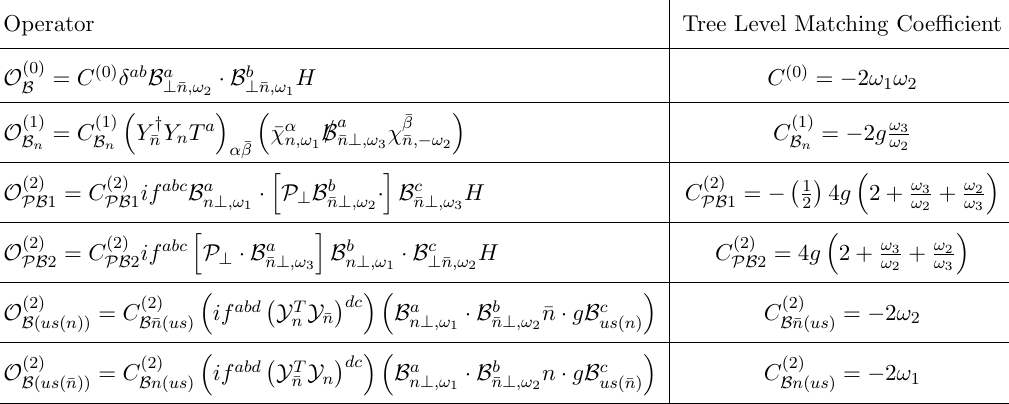
Table 1 . Hard scattering operators that contribute to the LL cross section to induced Higgs decay, along with their tree level matching coe(cid:14)cients. These operators and matching coe(cid:14)cients were derived in [32].